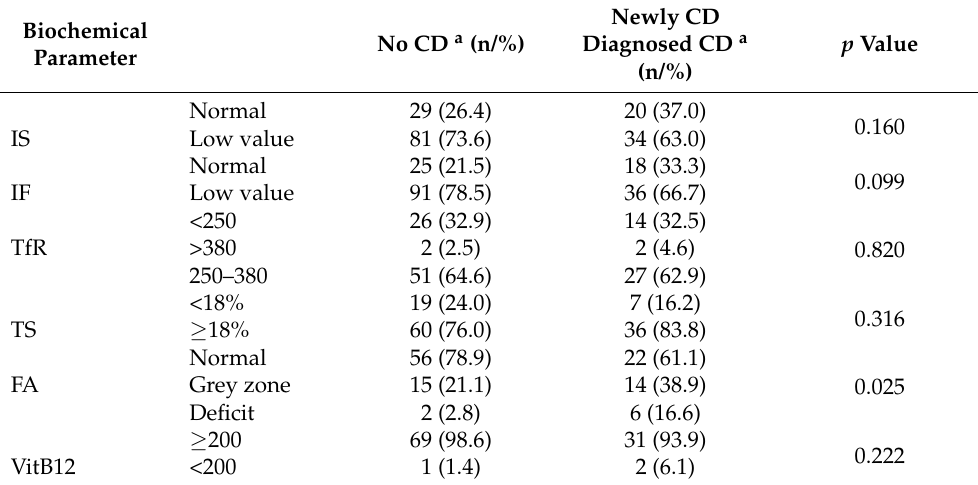
Table 5. Biochemical parameters. Comparison between no CD and newly CD diagnosed individuals.